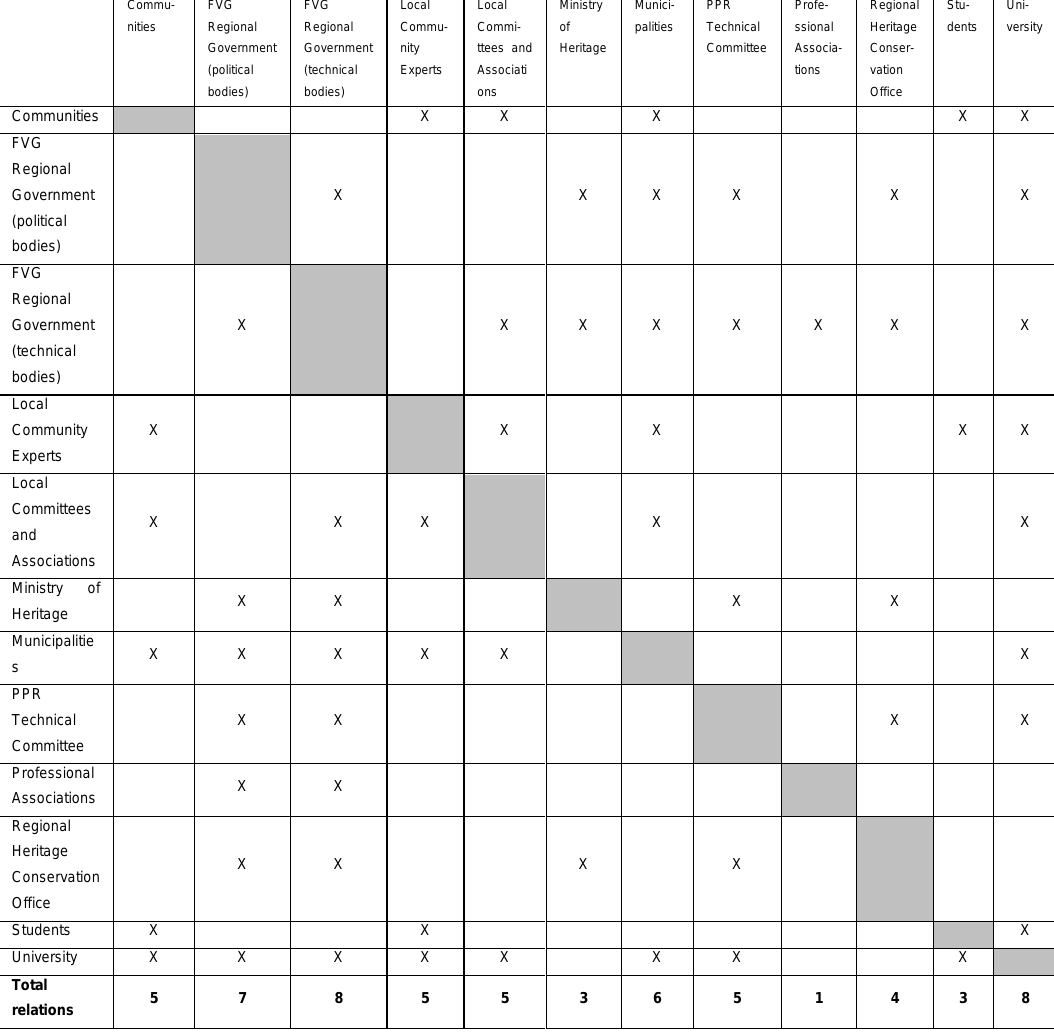
Table 1: FVG Regional Landscape Plan process: main actors and